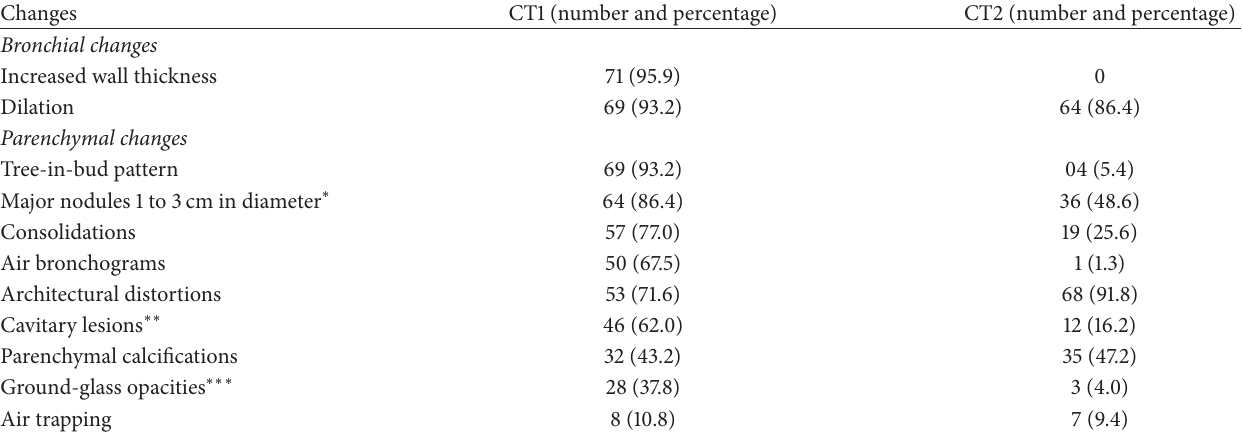
Table 2: Frequency of changes observed before treatment (CT1) and after treatment